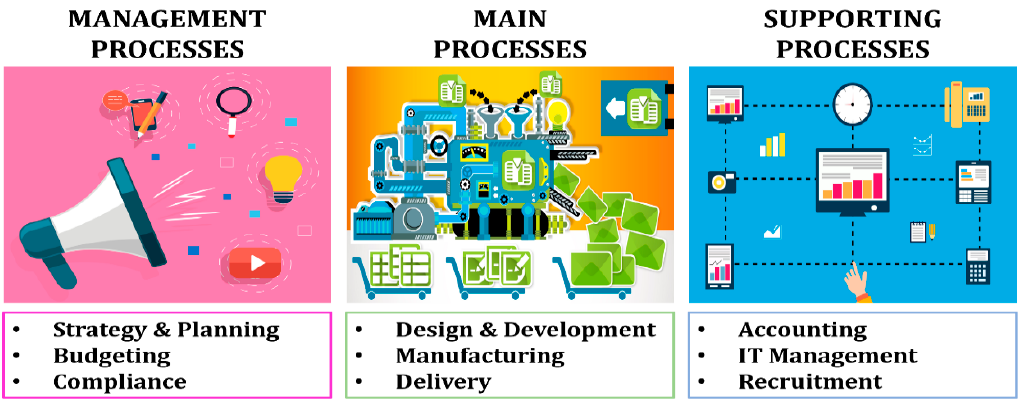
Figure 2. Different types of business processes. Figure 2. Di ff erent types of business